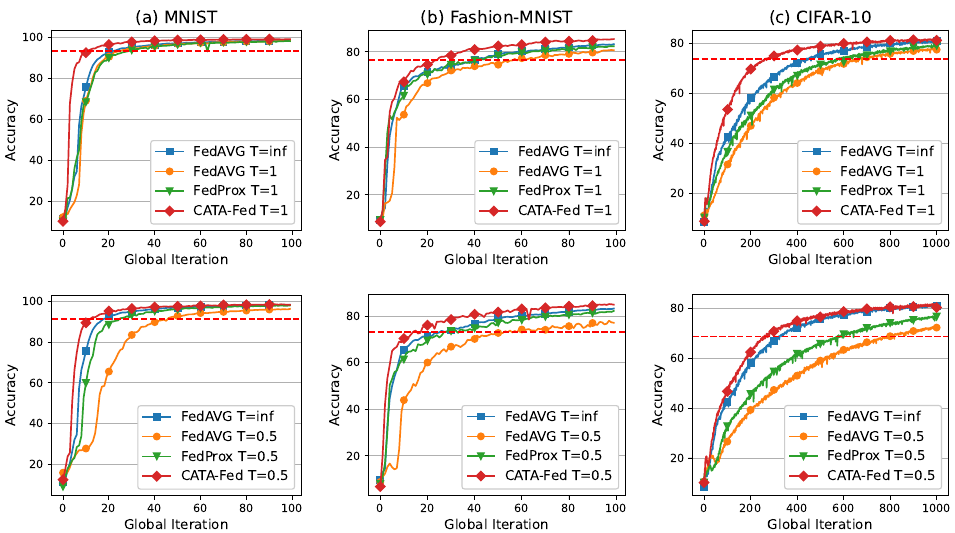
Figure 10. Test set accuracy vs. global iterations for ( a ) MNIST, ( b ) Fashion-MNIST, and ( c ) CIFAR-10 under IID setting with deadline T = 1 ( top ) and T = 0.5 ( bottom